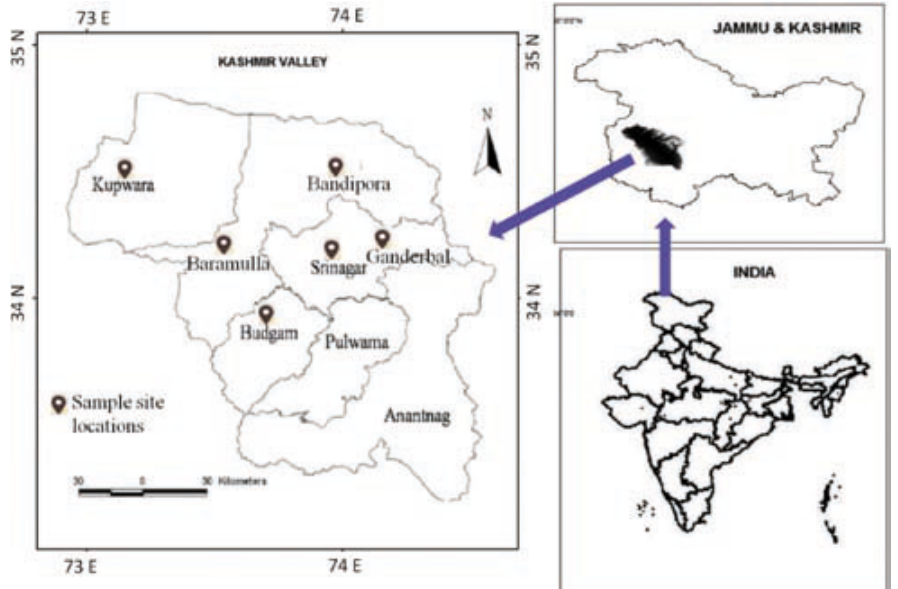
Fig.1. Map showing sample collection